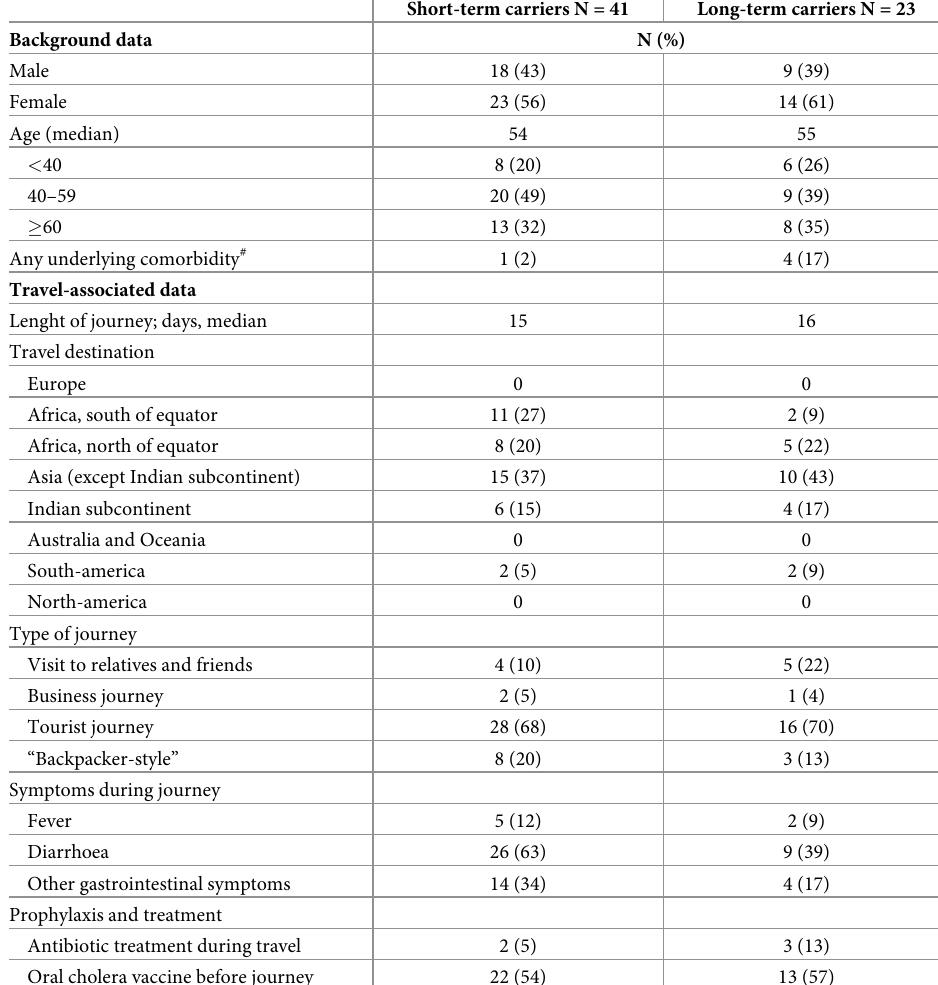
Table 1. Descriptive statistics of background and travel-associated data for short and long term carriers. # Under- lying comorbidities: diabetes, malignancy, inflammatory bowel disease (IBD), chronic urinary tract